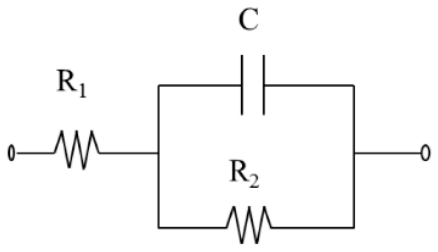
Figure 3. Randles equivalent circuit proposed to best fit.